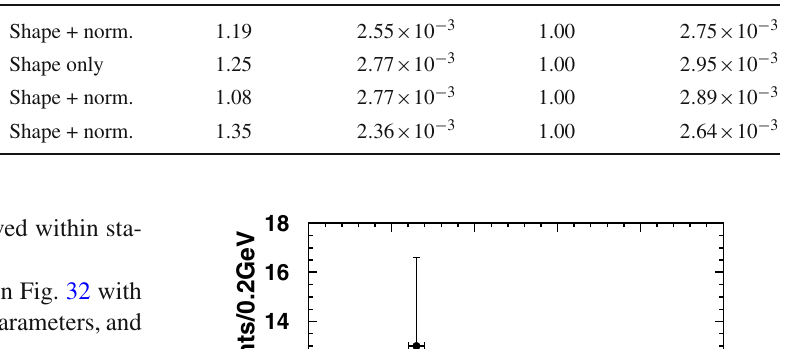
Table 10 Summary of the oscillation parameters at the best fit point for each fit condition